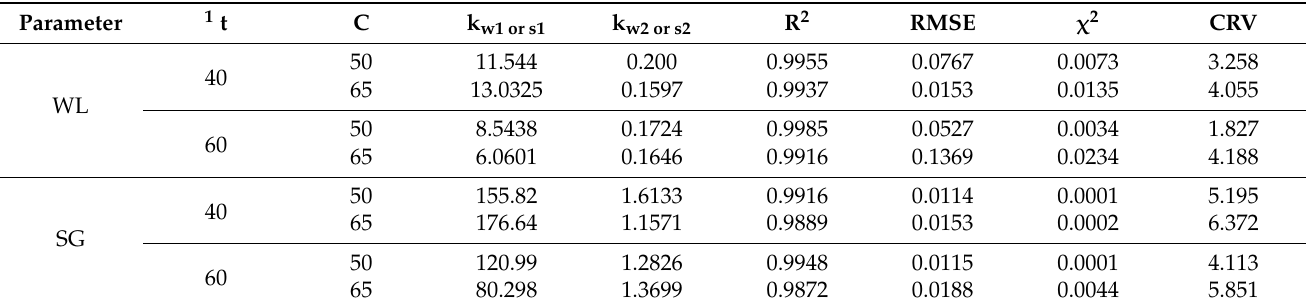
Table 3. Parameters of mathematical modeling used for the description of changes in WL (k w1 , k w2 ) and SG (k s1 , k s2 ) with statistical analysis.